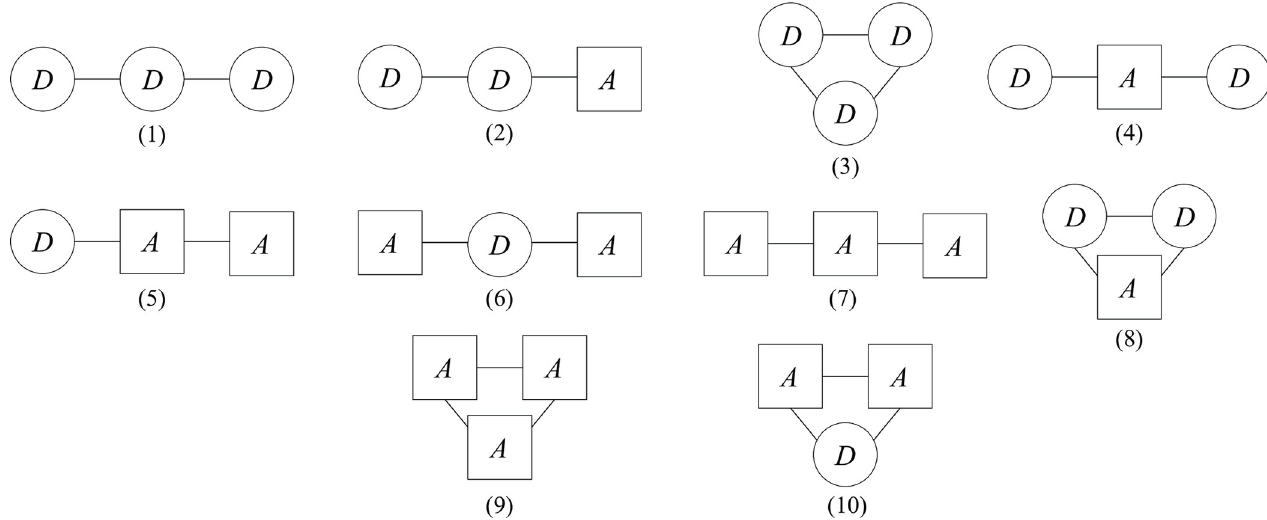
Fig 13. The structure of all possible conflicts between three groups ( D and A are defense and attack groups).